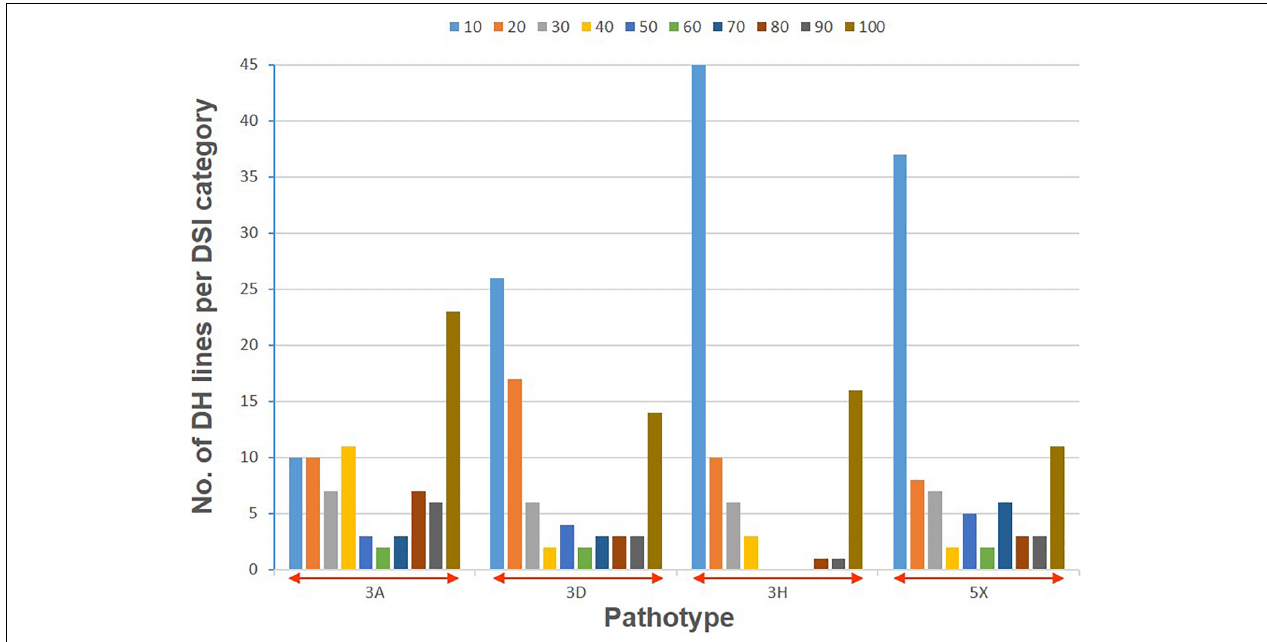
FIGURE 2 | Distribution of clubroot severity (disease severity index, DSI) following inoculation with four pathotypes (3A, 3D, 3H, and 5X) of P. brassicae in a doubled haploid (DH) population derived from a BC 2 plant of Brassica rapa ECD01 crossed with B. napus DH16516. Colors in each stacked column represent the proportion of the lines with a DSI value within that decile (= 10% range).